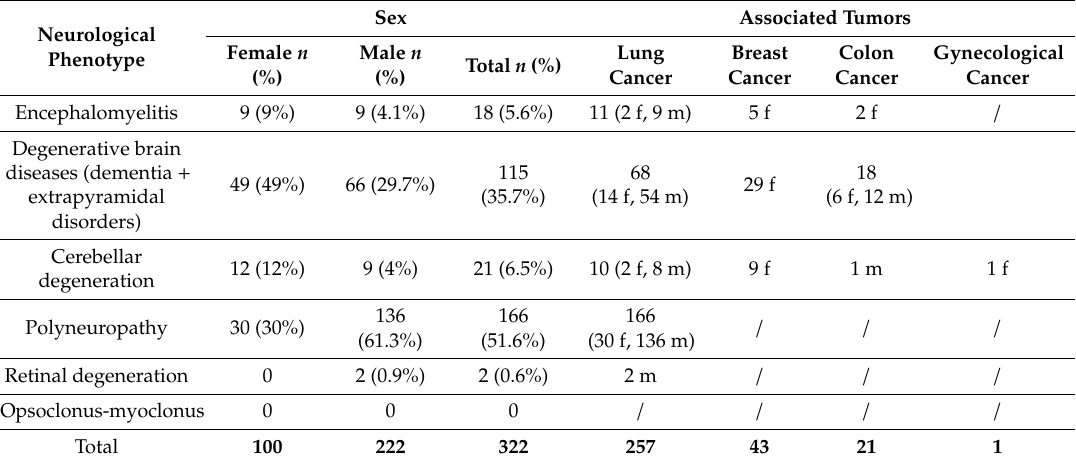
Table 1. Cases of pareneoplastic neurological syndromesassociated with tumors in the Lombardy region from 1998 to 2003. f = female, m =